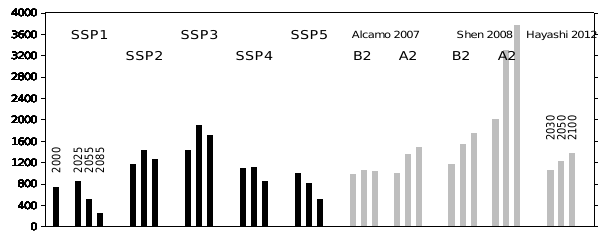
Fig. 10. Scenarios for total global withdrawal-based potential in- dustrial water demand (km 3 yr − 1 )